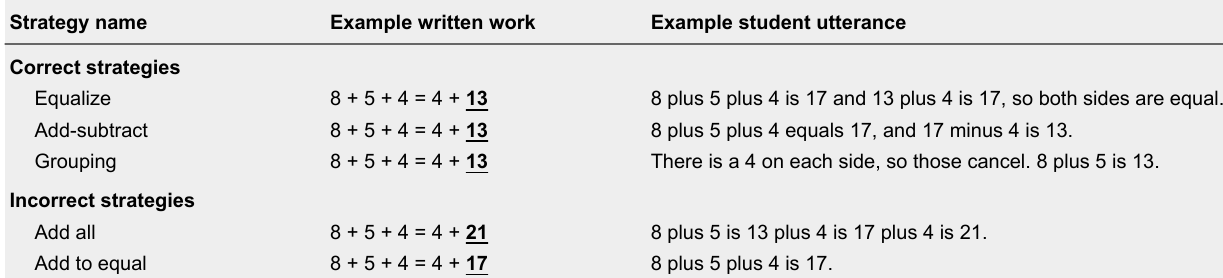
Common Strategies for Solving Mathematical Equivalence Problems. Based on Perry, Church, & Goldin-Meadow